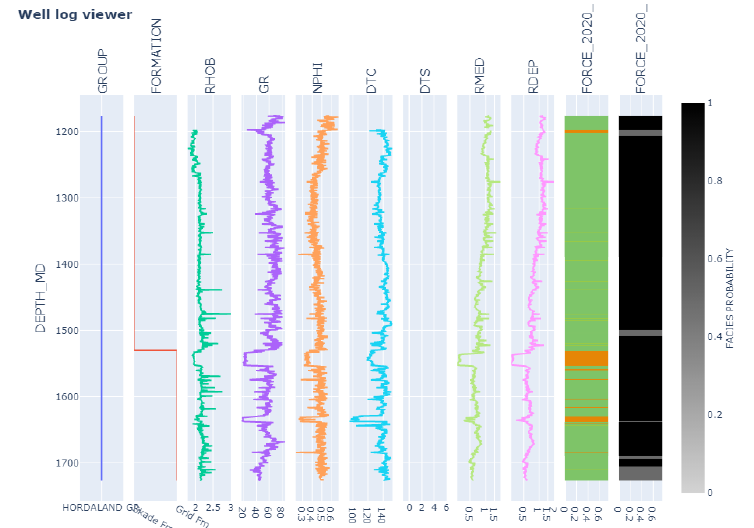
Figure 3. Visualization of well